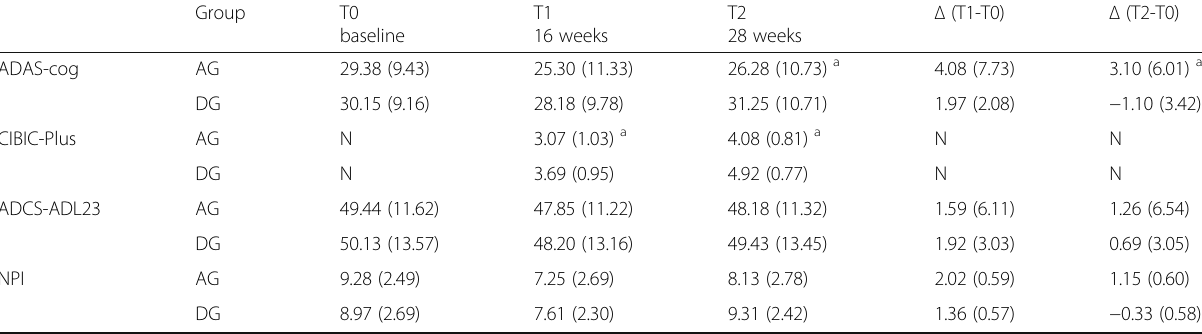
Table 2 Mean scores at all time points and change scores for ADAS-cog, CIBIC+, ADCS-ADL 23 and NPI